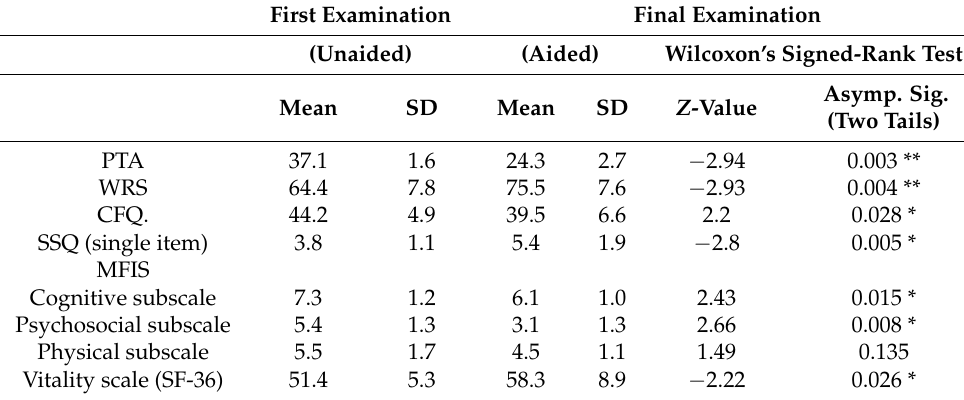
Table 2. Means and standard deviations (SD) of the hearing threshold (PTA), word recognition score (WRS), the Cognitive Failure Questionnaire (CFQ), the single item of the SSQ, and the Modified Fatigue Impact Scale (MFIS) subscales scores at the first and final assessment after patients’ acclimati- zation to hearing aids use are presented. The Wilcoxon signed rank test is expressed by Z -value and Asymptotic Significance (two tails). (**) = p < 0.005, (*) = p < 0.005.